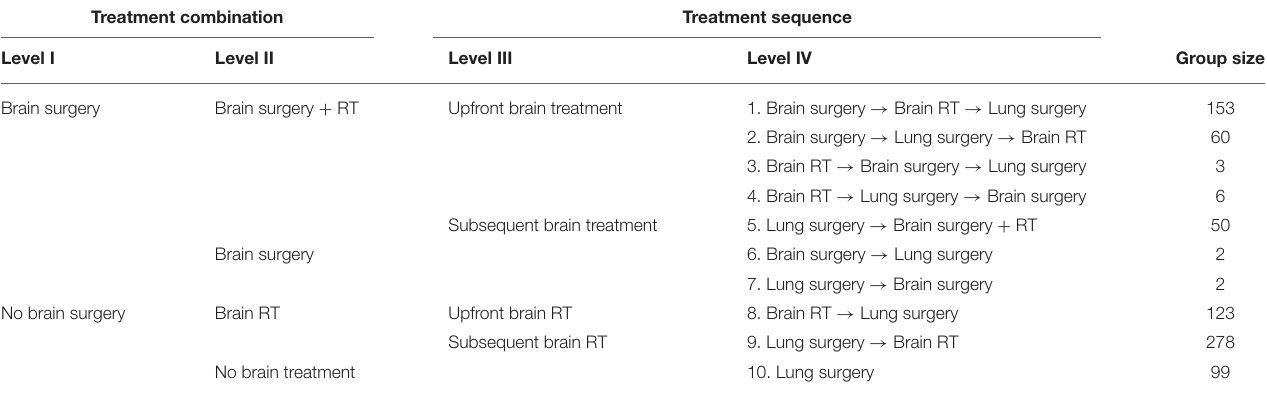
TABLE 1 | Patient